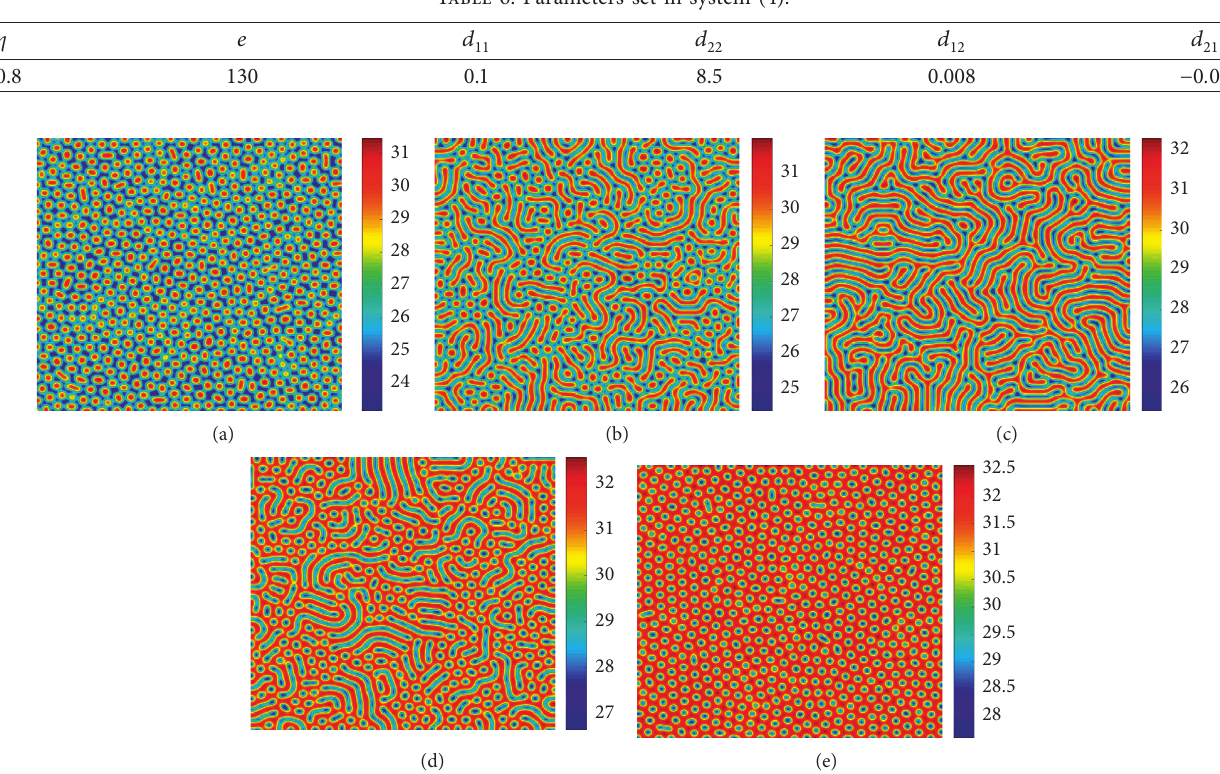
Figure 5: Iterations of hot spot pattern of the predator with c � 0 . 0105; other parameters are set as in Table 4. Iterations: (a) 0, (b) 20,000, (c) 30,000, and (d) 100,000. Table 6: Parameters set in system (4).